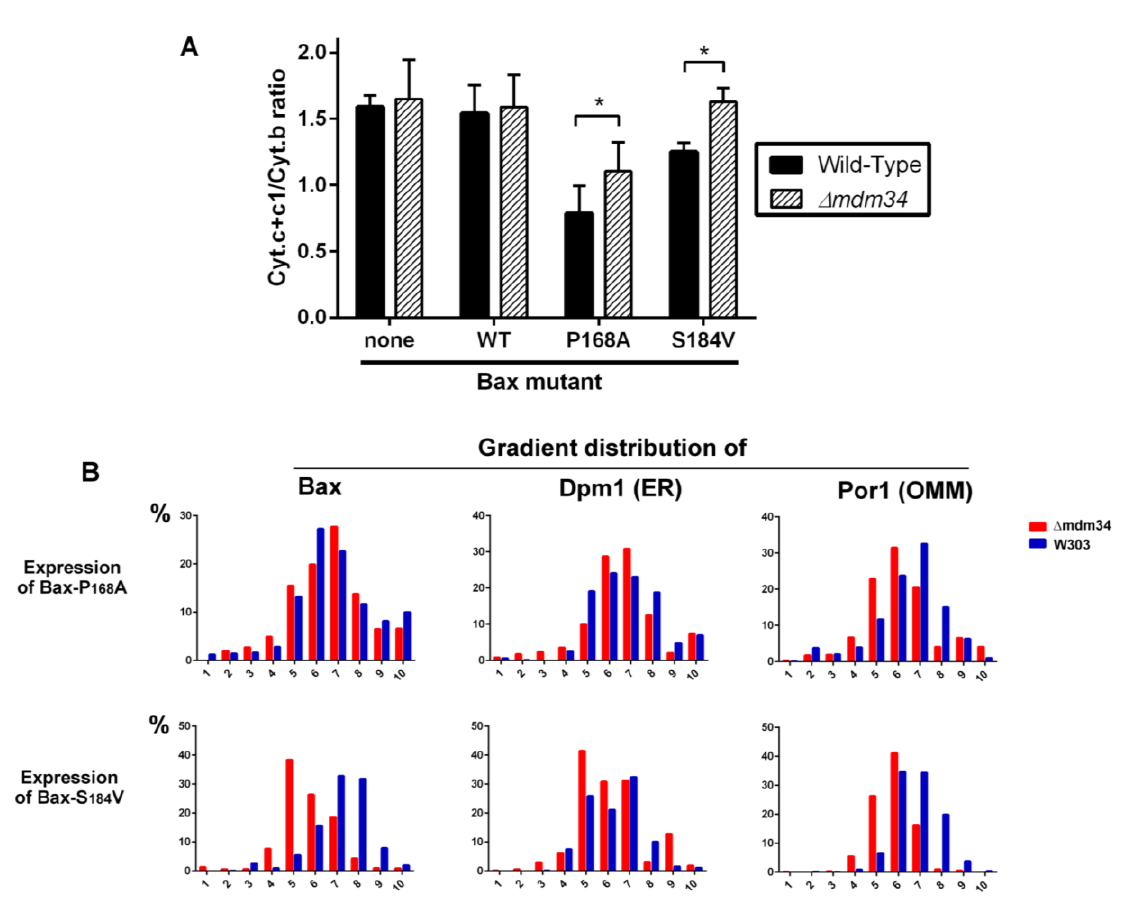
FIGURE 3: Bax-S184V looses the ability to release cytochrome c in Δ mdm34 cells. (A) Cytochrome c+c1/Cytochrome b ratios measured in mitochondria from different strains. Values are averages (± s.d.) of 4 to 6 independent experiments. (B) Distribution of Dpm1 (ER), Por1 (OMM) and Bax on a crude mitochondrial fraction separated on sucrose density gradients. Results are representative of 3 independent